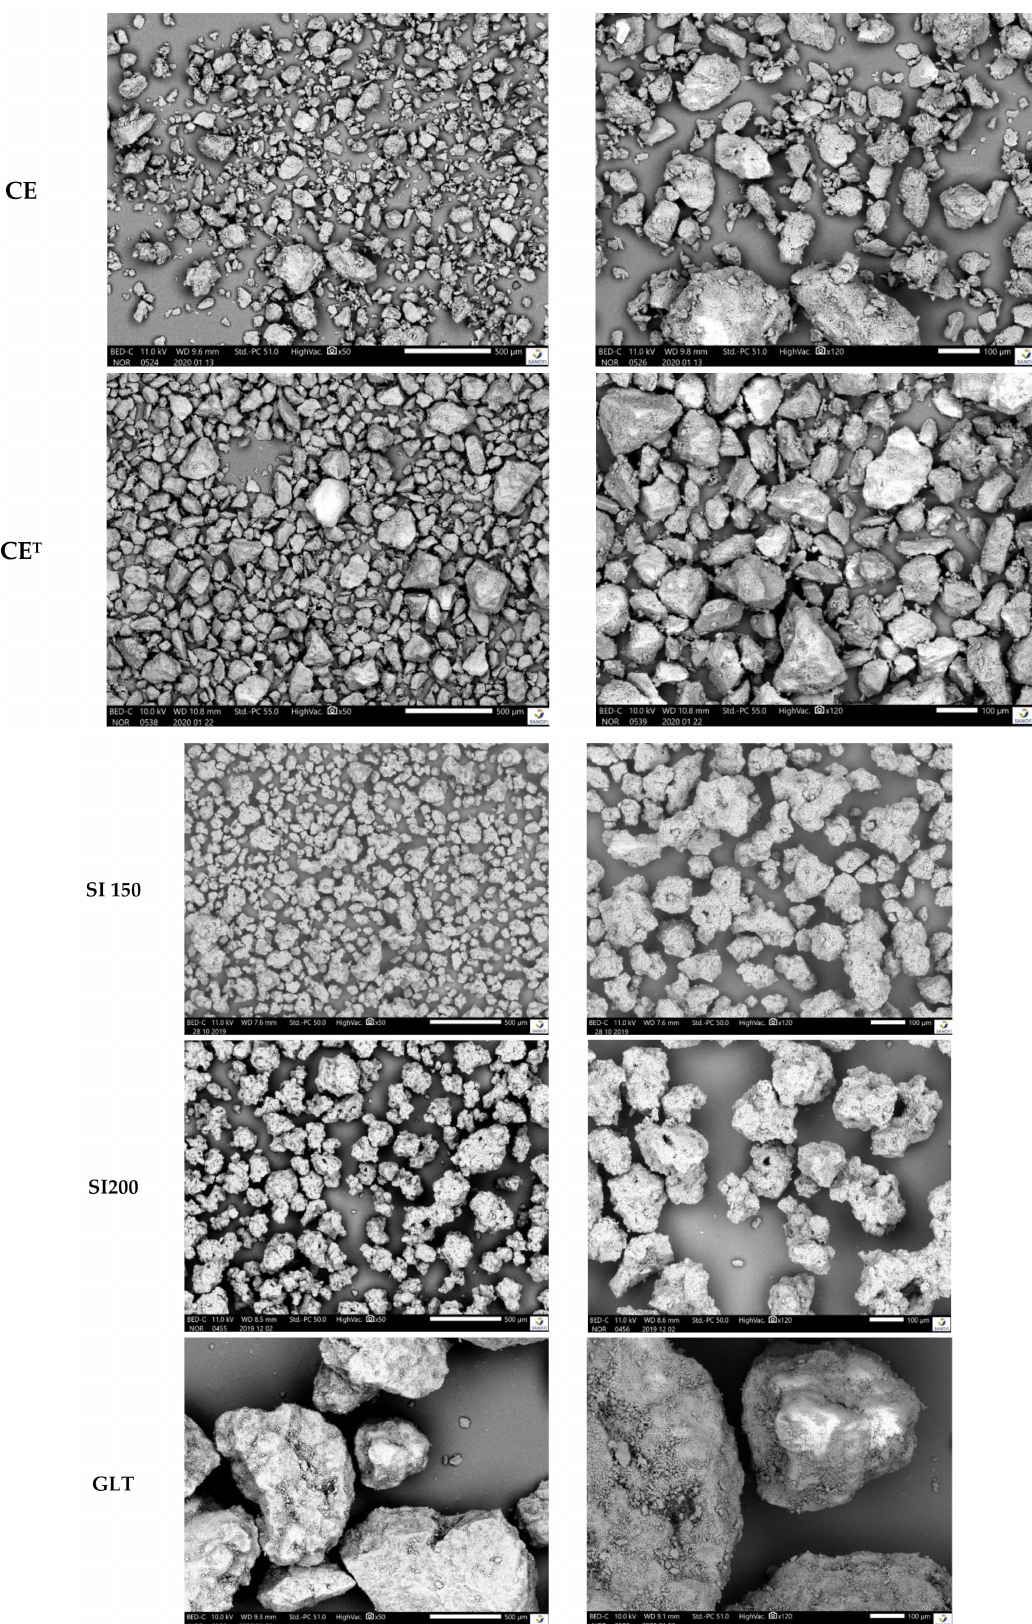
Figure 4. SEM pictures of D-Sorbitol from top to bottom CE, CE T , SI150, SI200 and GLT at X50 magnification ( top ) and X120 magnification ( bottom